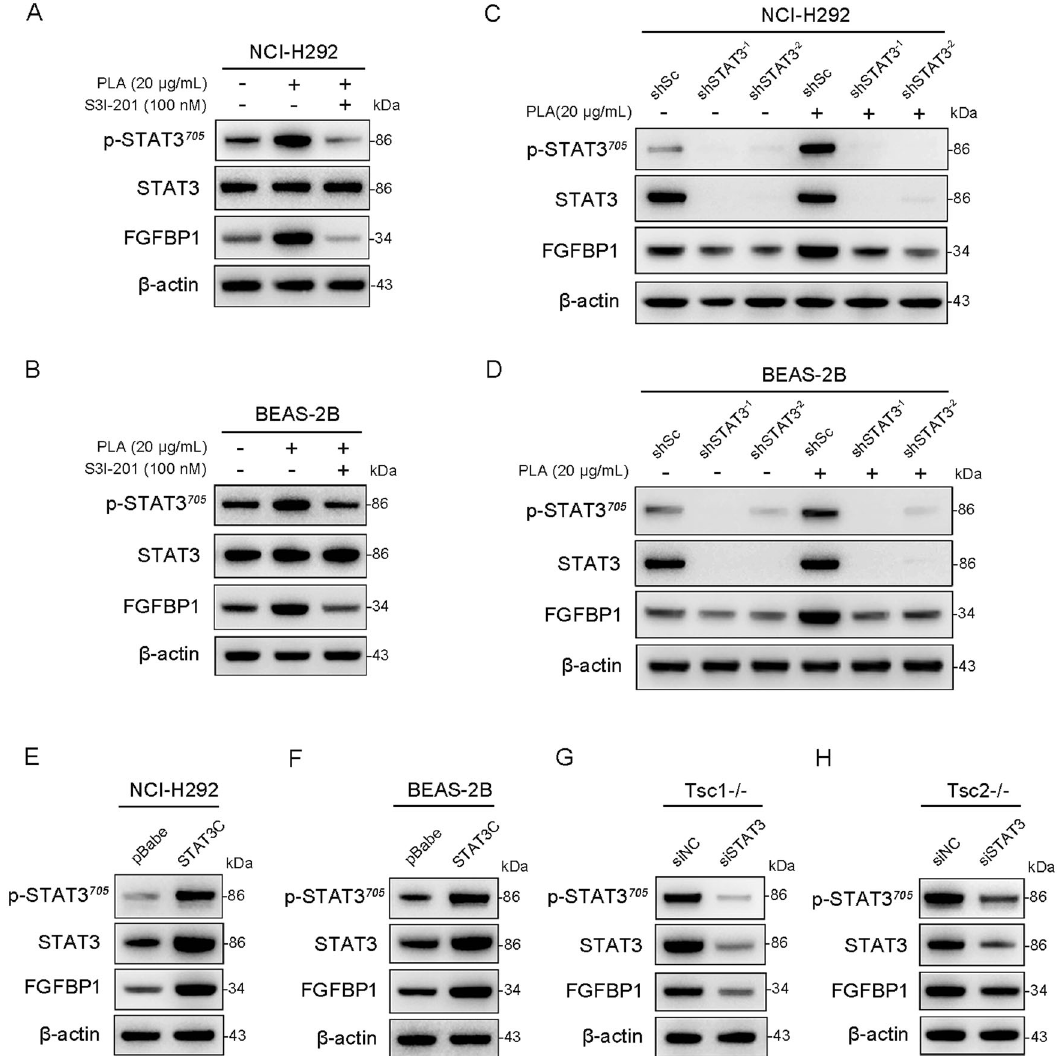
Fig. 4 mTORC1 enhances FGFBP1 expression through activation of STAT3. A , B NCI-H292 ( A ) and BEAS-2B ( B ) cells were pretreated with PLA (20 μ g/mL, 12 h) before the addition of S3I-201 (100 nM) for 12 h. C , D NCI-H292 ( C ) and BEAS-2B ( D ) cells, stably expressed lentivirus shSTAT3 -1 , shSTAT3 -2 , or shSc, were treated with or without PLA (20 μ g/mL, 24 h). E , F NCI-H292 ( E ) and BEAS-2B ( F ) cells were transfected with pBabe-STAT3C, a constitutively active STAT3 mutant, or the control vector pBabe. G , H siRNAs against STAT3 (siSTAT3) or the control (siNC) were transfected into Tsc1 − / − MEFs ( G ) and Tsc2 − / − MEFs ( H ). A – H Cell lysates of the indicated cells were harvested for immunoblot analysis with the indicated antibodies. All experiments were performed in